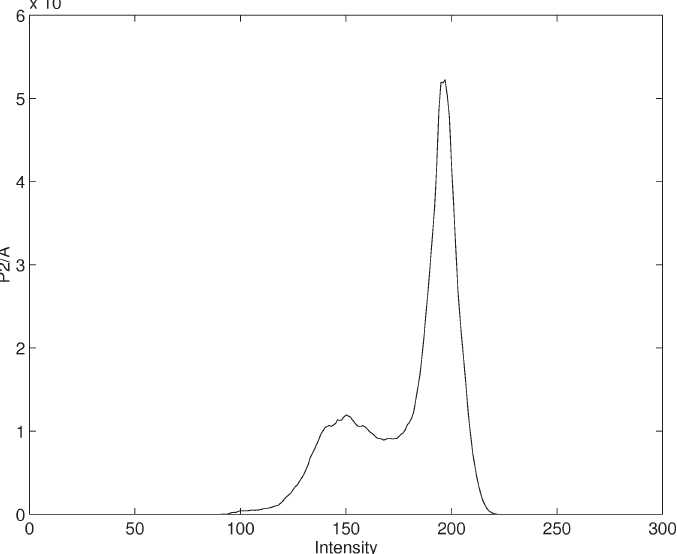
Fig. 5. Example of histogram with two significant peaks, despite the fact that the maximum after the longest sequence of increasing values is equivalent to the maximum before the longest sequence of decreasing